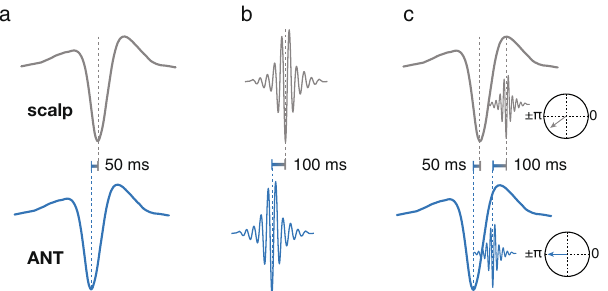
Fig. 8 | Schematic overview of the interplay between sleep oscillations recor- dedintheANTandonthescalp.a ANTSOs(bottom,blue)preferentiallypeakon average ~50ms before the emergence of neocortical SOs (top, gray). b ANT spin- dles(bottom,blue)peakonaverage100msbeforeneocorticalspindles(top,gray). c ANT spindles couple to earlier ANT SO phases (bottom, blue) than neocortical spindles couple to neocortical SOs (top, gray). While neocortical oscillations show theprototypicalSO-spindlemodulation(i.e.,nestingofspindlestowardstheSOup- state), spindles in the ANT start closer to the ANT SO down-state. The insets illus- trate the difference inthe phase locking of spindlestartto theirrespective SO(the phase of SO down-states corresponds to ± π